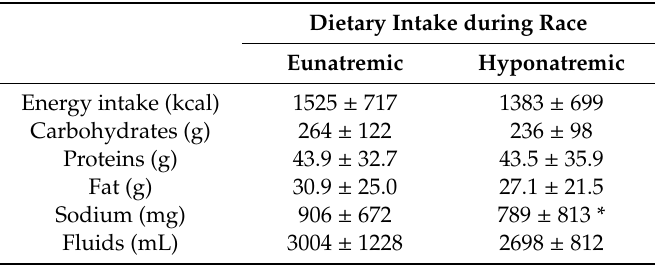
Table 3. Participants’ energy intake, nutritional evaluation of macro- and micronutrient components, and fluids consumption during ultra-endurance